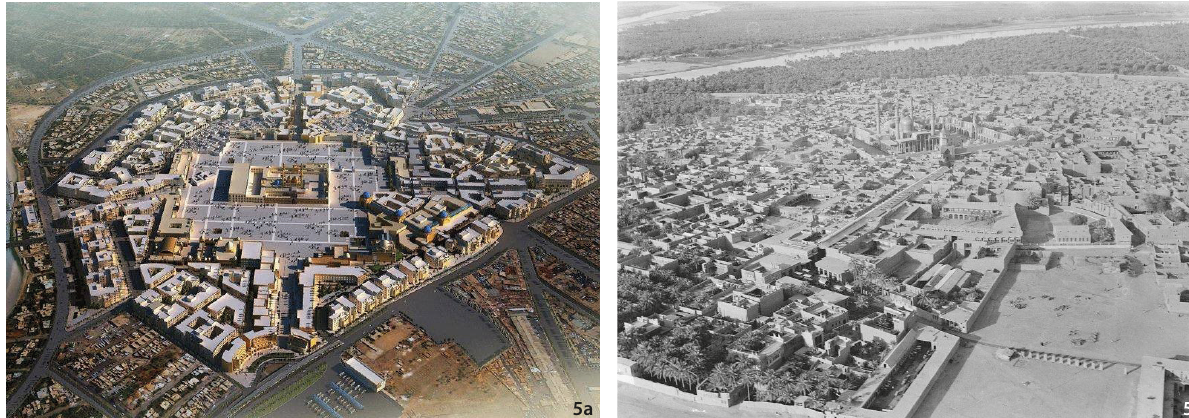
Figure 5a A proposal for the ‘developmental maintenance circle’ (Source: Private library of Ihsan Fathi & Muaffaq al-Taey). Figure 5b The real urban scene of the Mahalla; (Source: Private library of Ihsan Fathi & Muaffaq